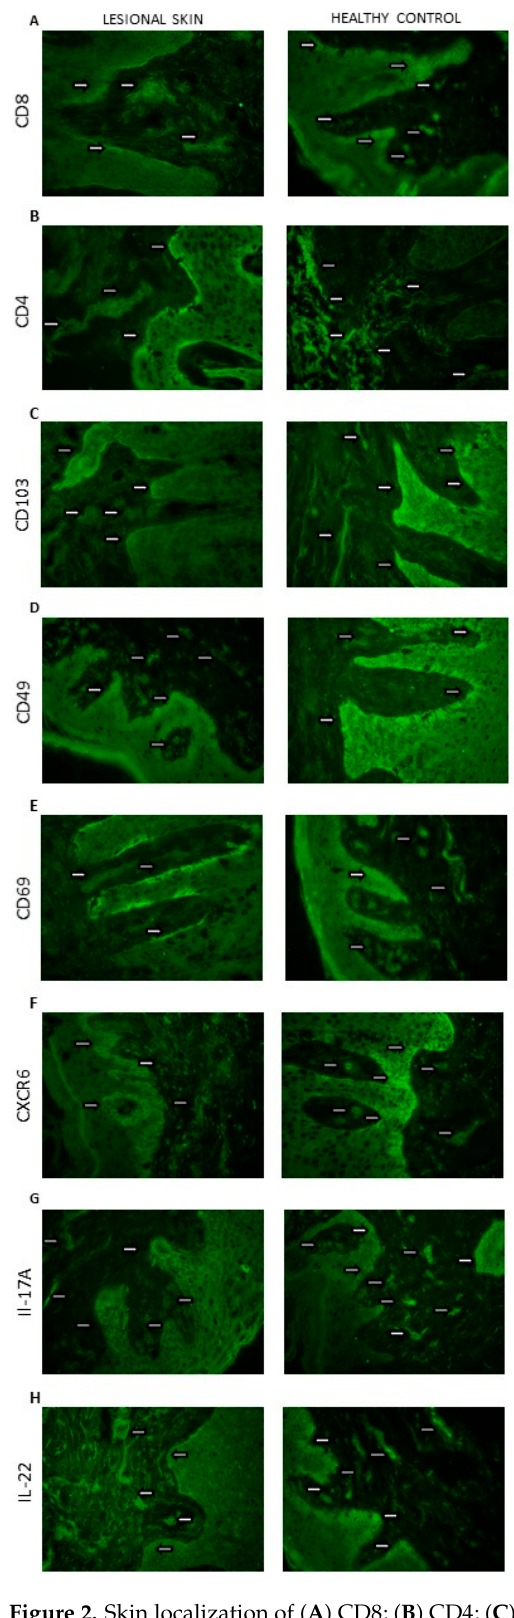
Figure 2. Skin localization of ( A ) CD8; ( B ) CD4; ( C ) CD103; ( D ) CD49; ( E ) CD69; ( F ) CXCR6; ( G ) IL- 17A; ( H ) IL-22 proteins (the representative sections): lesional skin ( n = 32, dermis and epidermis) and healthy control ( n = 10, dermis and epidermis). The proteins are marked in green (fluorescein). Magnification: 500 ×